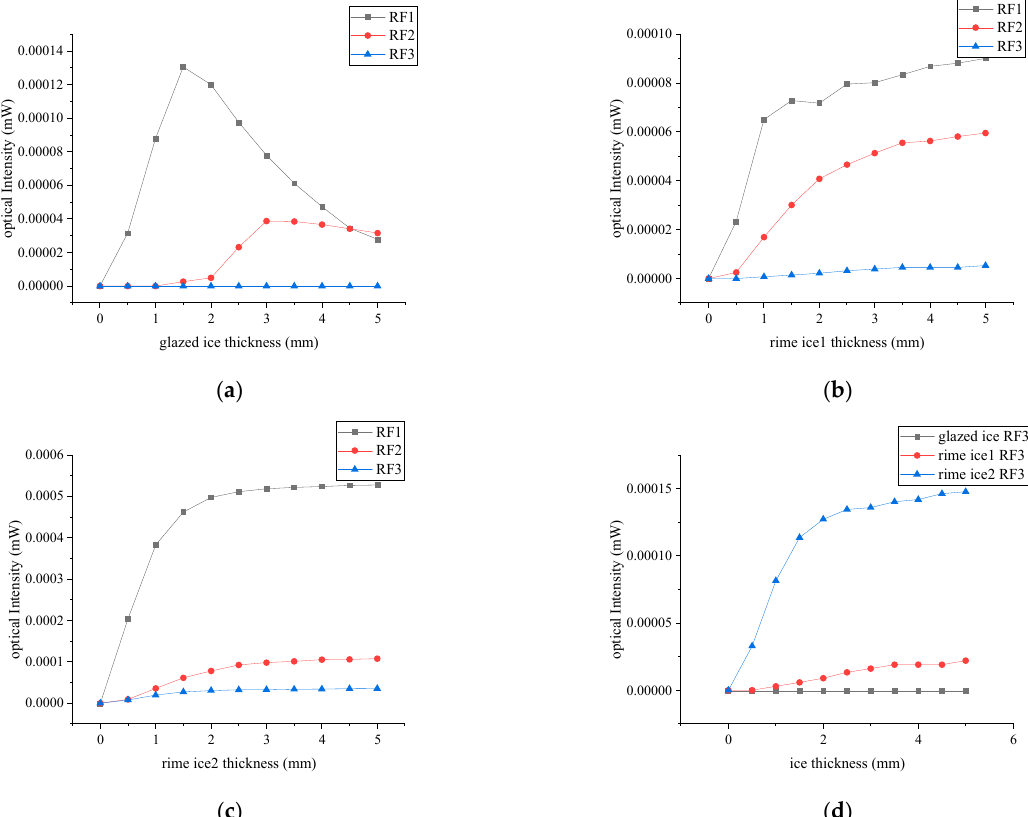
Figure 5. Relationship between received light intensity and ice thickness. ( a ) Received light intensity curve at glazed ice; ( b ) received light intensity curve at rime ice 1; ( c ) received light intensity curve at rime ice 2; ( d ) RF3 reception curves of di ff erent ice types.